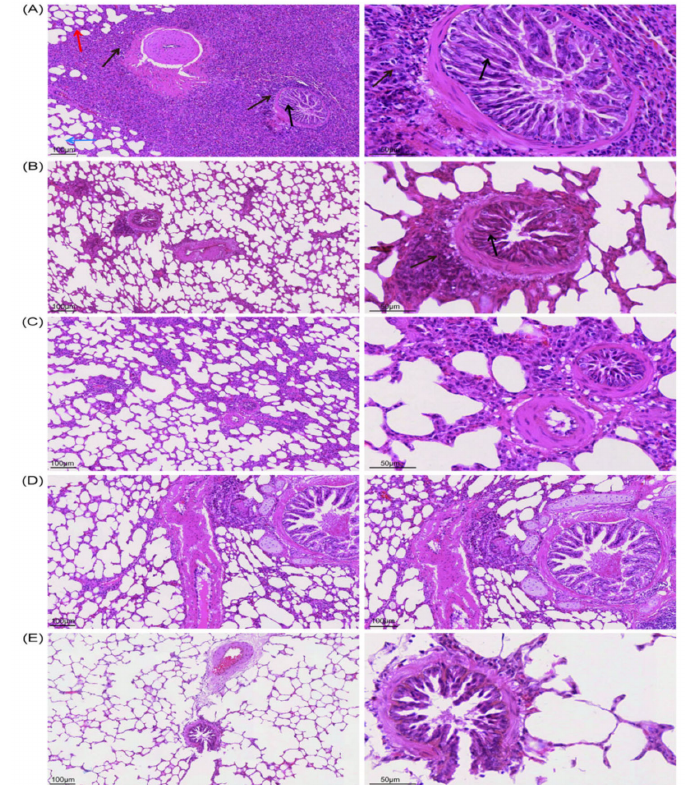
Figure 4. Histopathology of guinea pig lung slices. ( A ) Challenge control group (10 × 20), black arrows show bronchi were compressed, with bulging, bronchospasm, contraction; brown arrows show peripheral lymphocytes and monocyte infiltration, peribronchitis or tubular formation; red arrows show narrowing of alveolar septum and emphysema. ( B ) BoHV − 1 immune group (10 × 20). ( C ) BoHV − 1 ∆ gE immunization group (10 × 20). ( D ) BoHV − 1 gE/E2 − Linker − E2 + immunization group (10 × 20). ( E ) Blank control group (10 ×